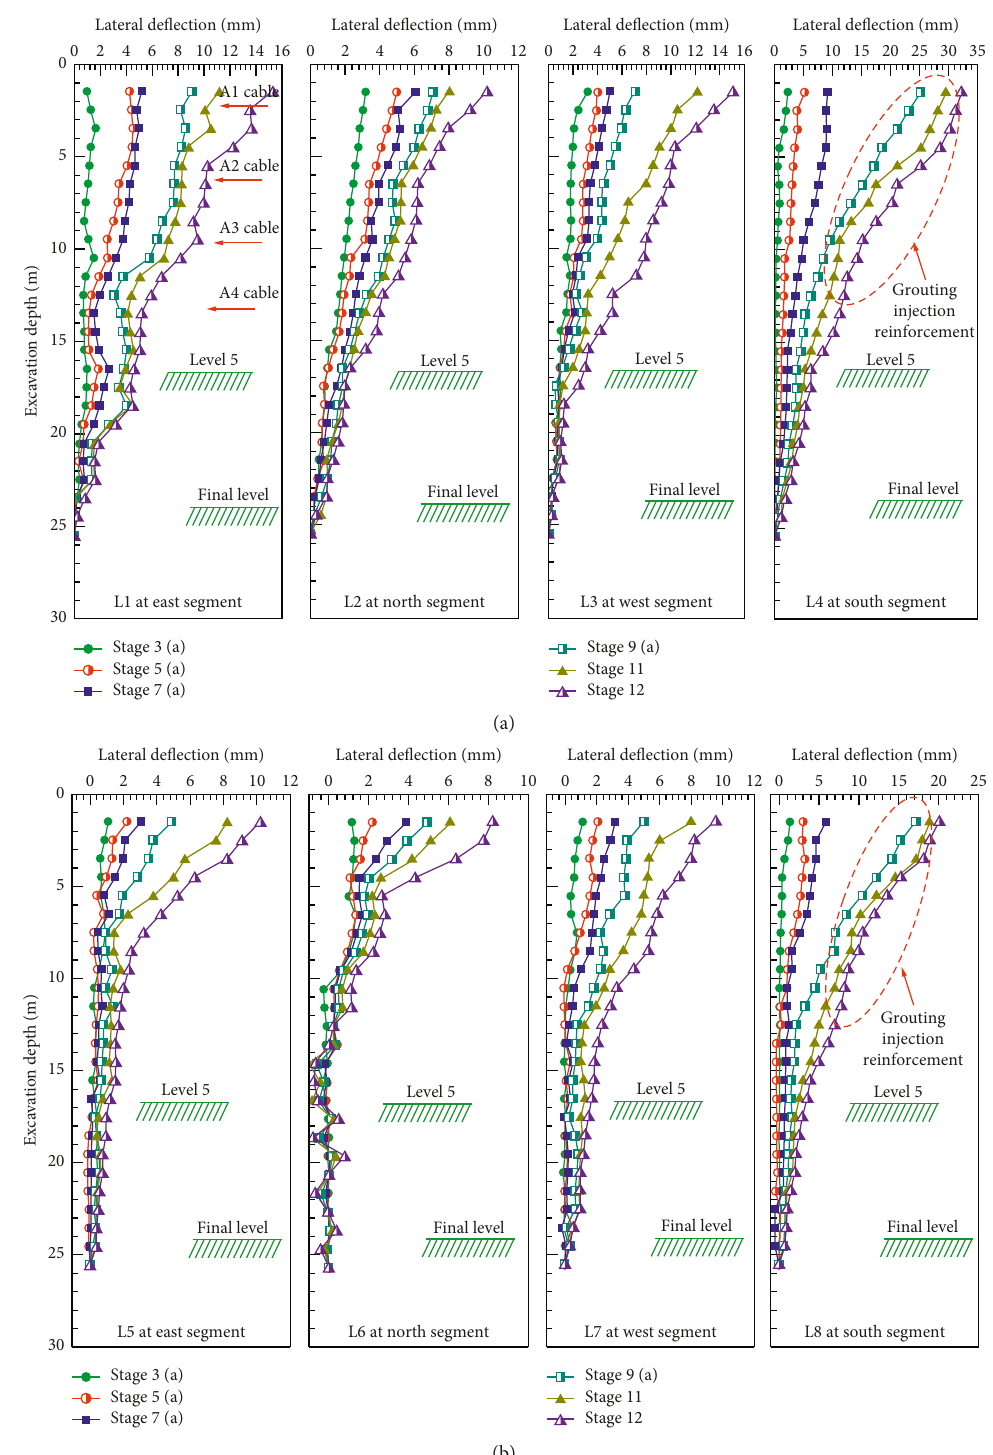
Figure 10: Horizontal deformations of wall deflections and lateral soil movements. (a) The lateral wall deflections. (b) The lateral soil